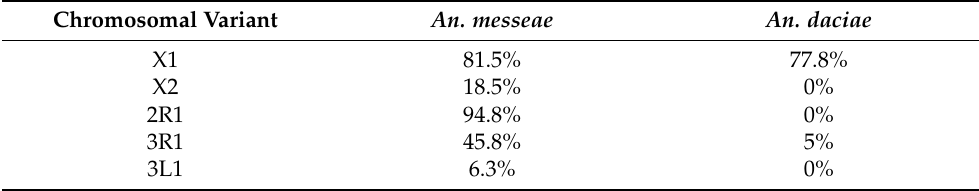
Table 3. Frequencies of the chromosomal variants in populations from Teguldet.